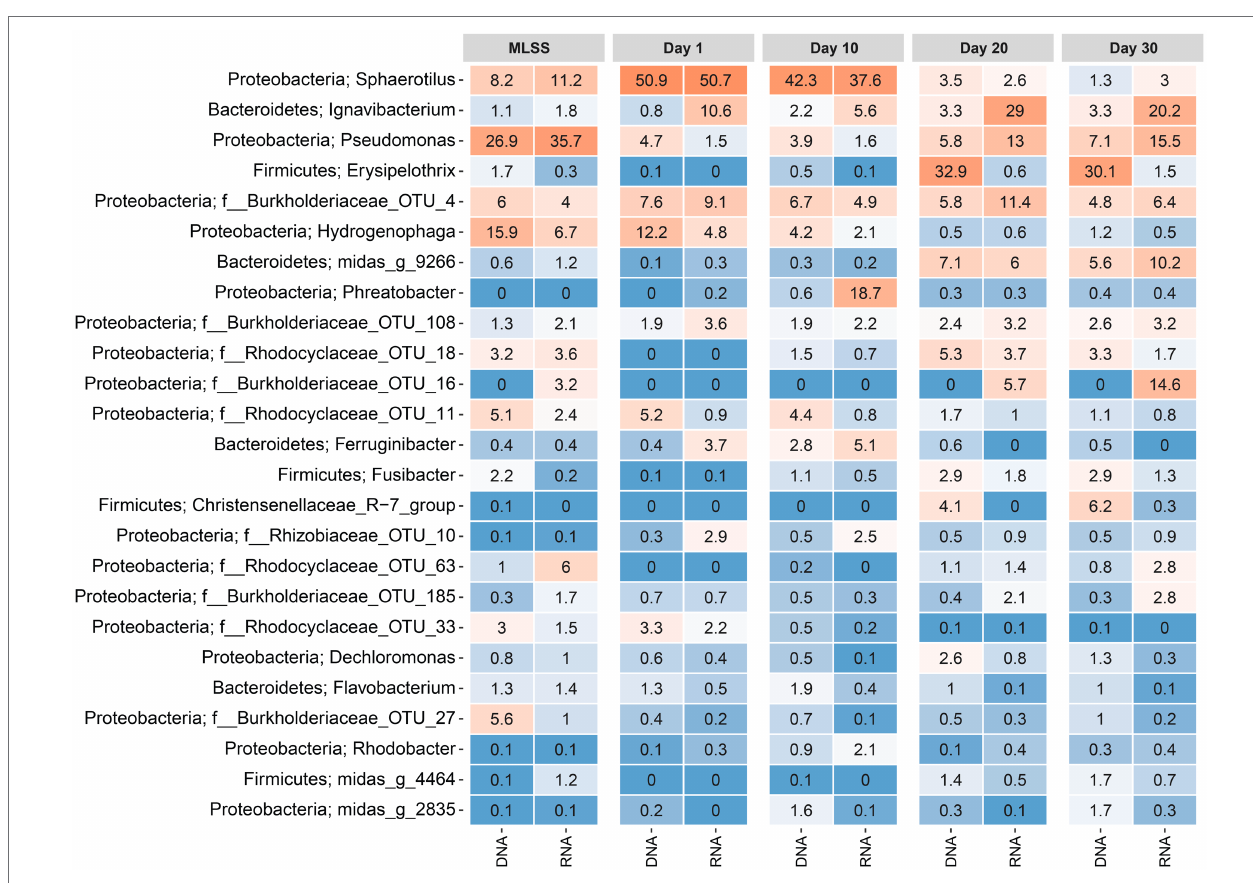
FIGURE 3 | Heatmap distribution of the top 25 taxa classified down to genus-level or the lowest classifiable taxonomic level (f, o, c, and p represent genus, family, order, class, and phylum, respectively) derived from average relative reads abundance for mixed liquor, suspended sludge, and membrane biofilms. MLSS corresponds to the mixed liquor suspended solids sample. Day 1, Day 10, Day 20, and Day 30 refer to sampling days 1, 10, 20, and 30, respectively. The color intensity in each cell reflects relative reads abundance of taxa in the corresponding sample. Similarly, DNA and RNA represent the 16S rRNA amplicon sequencing dataset from DNA and cDNA, respectively. The heatmap was generated based on a rarefied dataset sub-sampled to 4,386 sequences per sample. The ampvis2 package was used to generate the heatmap by averaging the relative abundances of all the samples (i.e., different materials with and without flux) for each sampling